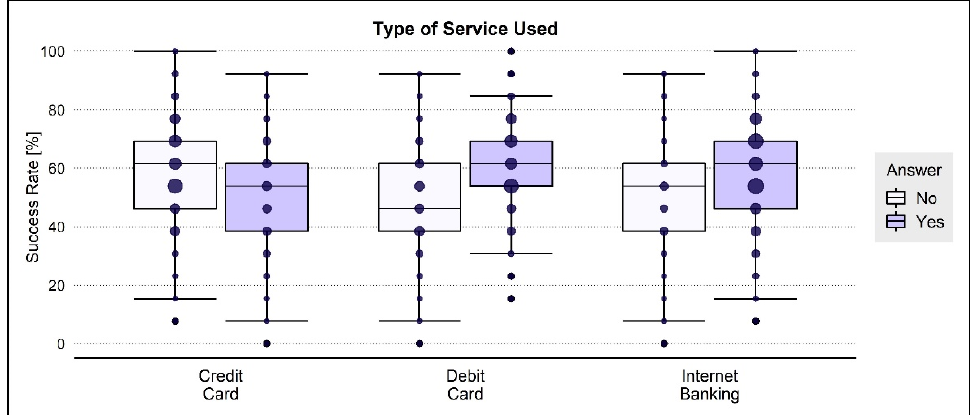
Figure 6. Success rate of students in the financial literacy test depending on the type of services used by students.